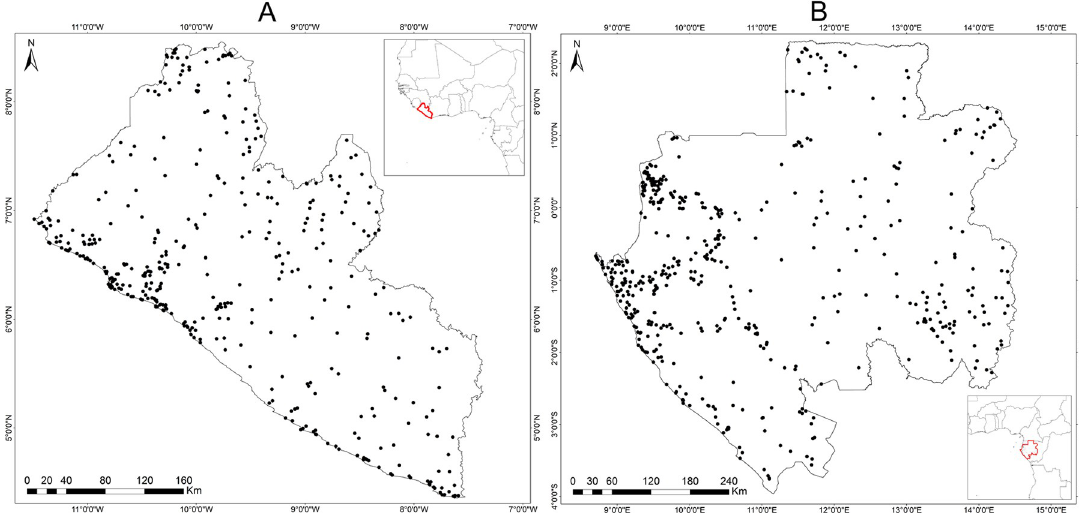
Fig 4. Spatial distribution of the 500 validation samples (50 for each land cover class) for the Liberia (A) and Gabon (B) land cover map. The locations where the 30 x 30 m footprint samples have been generated are shown as black points.